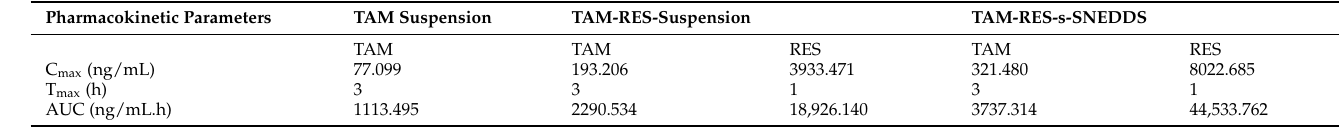
Table 4. Pharmacokinetic